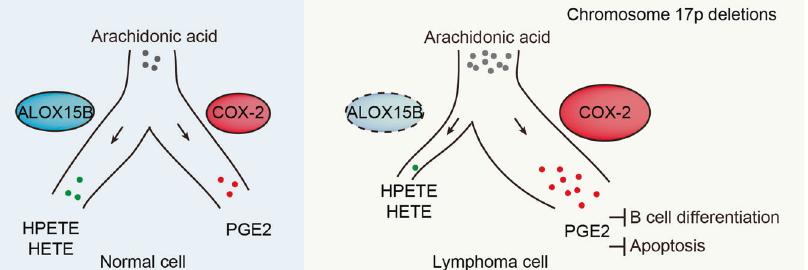
Fig. 5 Unbalanced arachidonate lipoxygenase and cyclooxygenase pathway in 17p-deleted lymphomas. Schematic representation showing that arachidonate lipoxygenase and cyclooxygenase pathway in normal cell (left) or lymphoma cells with chromosome 17p deletions